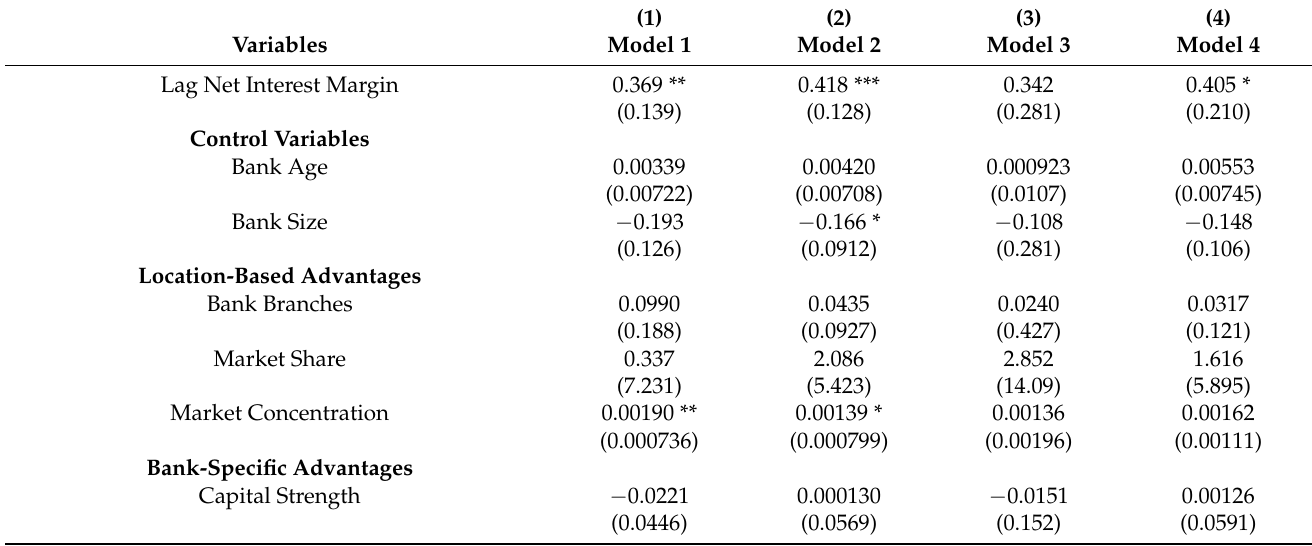
Table 10. Model of comparing dynamic cost of foreign liability with location-specific advantages (H4) in period: